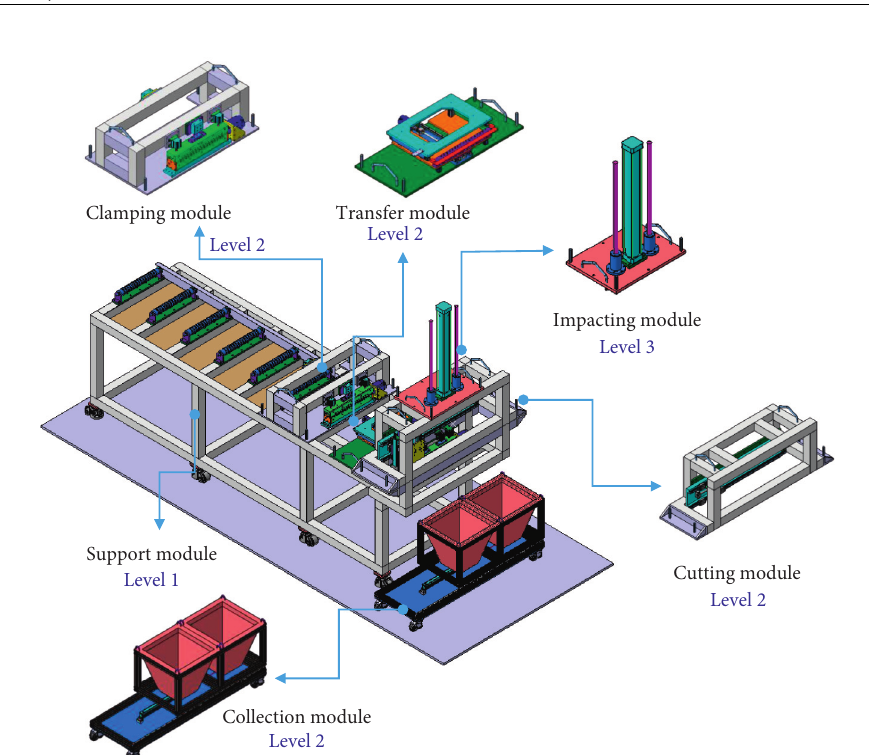
Figure 11: Cutter modules configuration